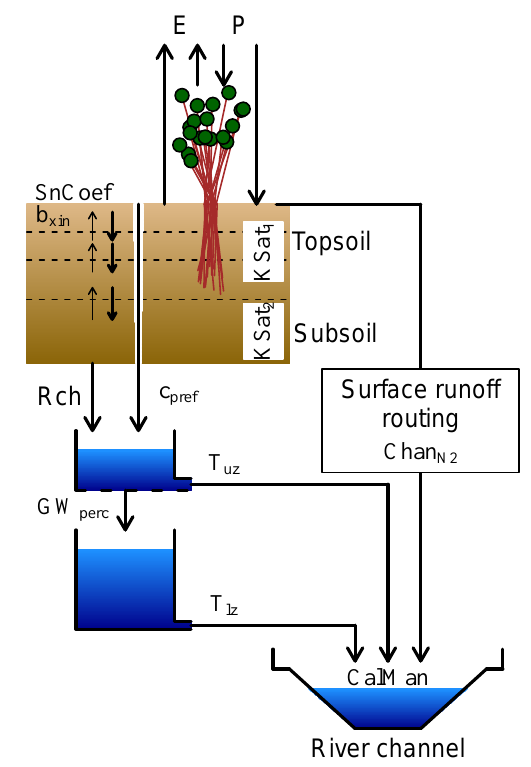
Figure 2. LISFLOOD model set-up, with fluxes; precipitation ( P ), evaporation ( E ), recharge from the unsaturated zone to the ground- water (Rch). The calibration parameters of the model are snowmelt coefficient (SnCoef), Xinanjiang shape parameter ( b xin ), saturated conductivity of the topsoil (KSat 1 ), saturated conductivity of the subsoil (KSat 2 ), empirical shape parameter preferential macro-pore flow ( c pref ), maximum percolation rate from upper to lower ground- water (GW prec ), reservoir constant upper groundwater ( T u z ), reser- voir constant lower groundwater ( T l z ), surface runoff roughness co- efficient (Chan N 2 ), and the channel’s Manning roughness coeffi- cient